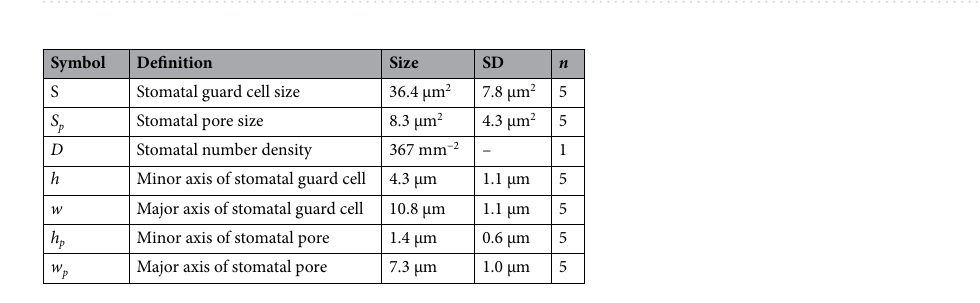
Table 1. Dimensions of stomata on the adaxial surface of Perilla frutescens .